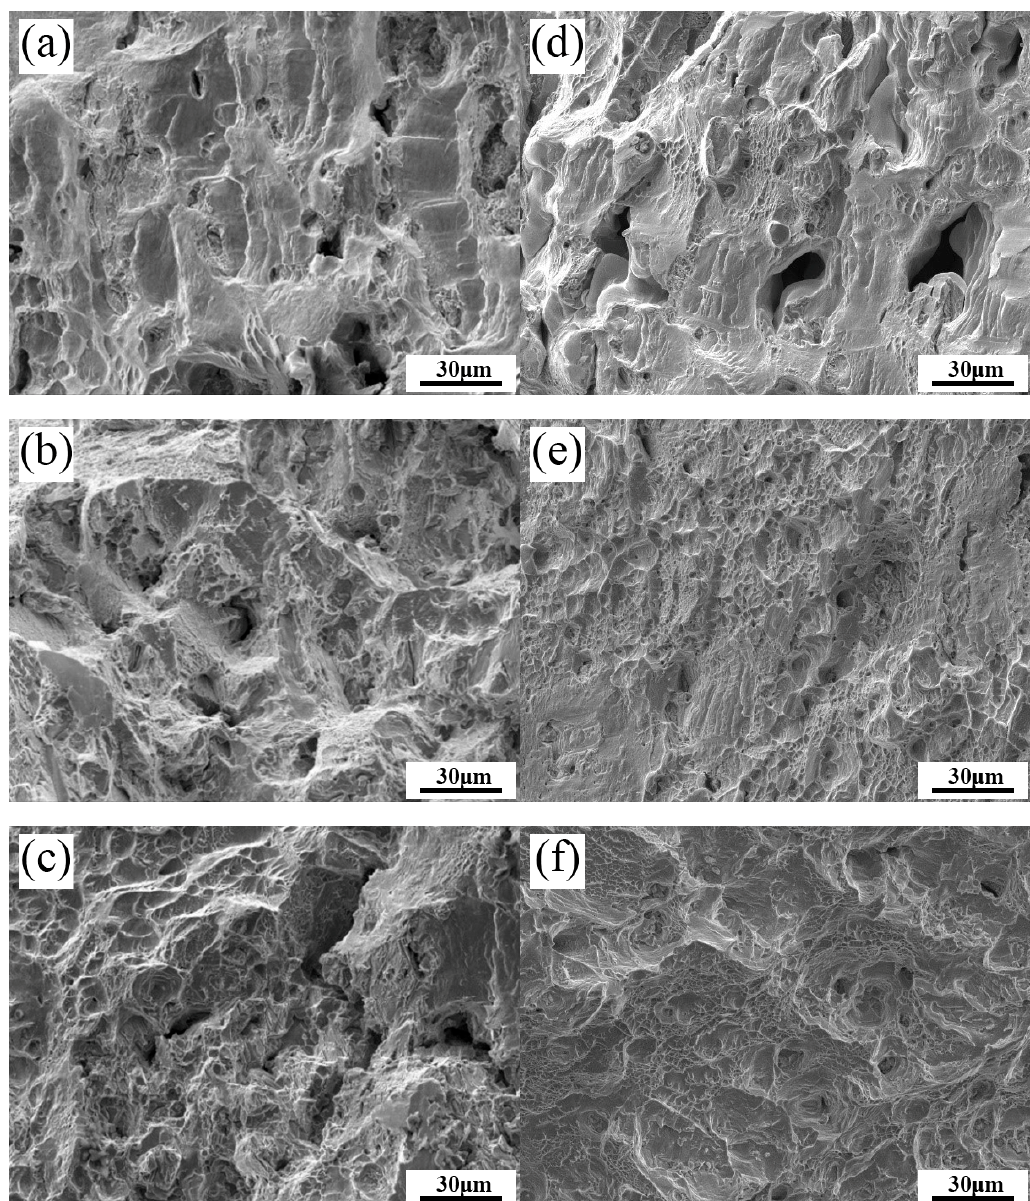
Figure 8. SEM fractographs of the tensile tested specimens of the Inconel 718 superalloys: SHT, HIP + STA, and HIP + DA at room temperature ( a – c ) and at 650 °C ( d – f ), respectively.